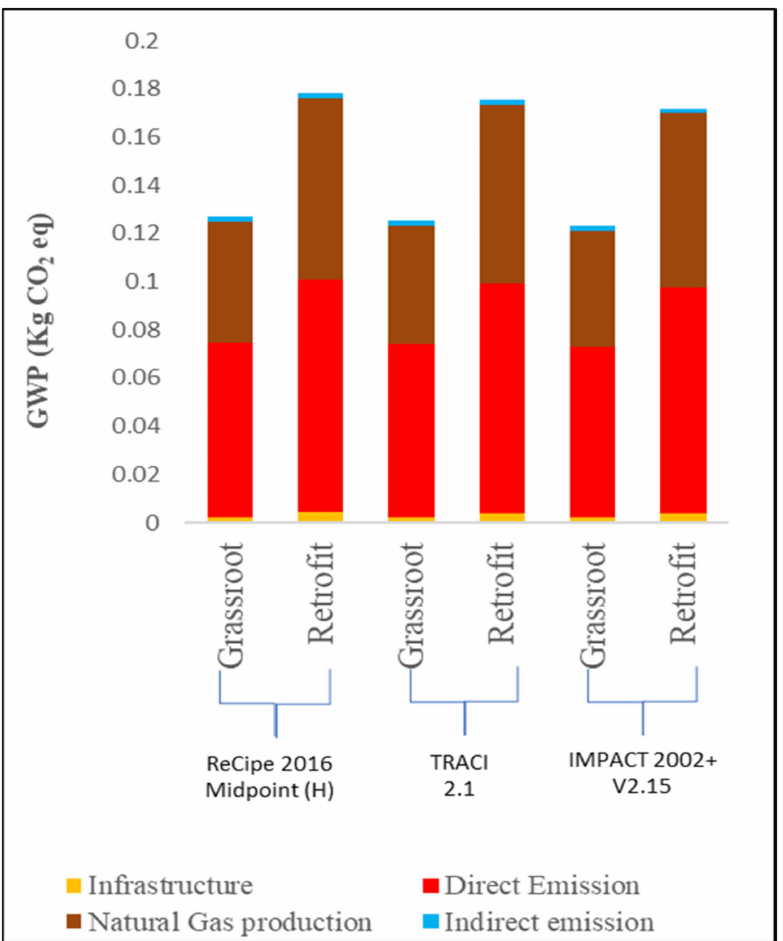
Figure 6. GWP Impact score and process